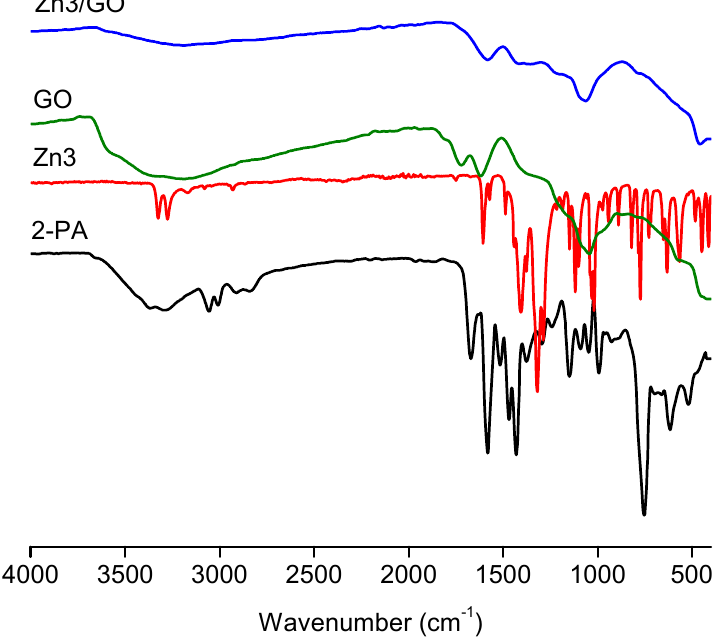
Figure 2. FT–IR spectra of the ligand 2–PA, GO, Zn3 and Zn3 /GO.